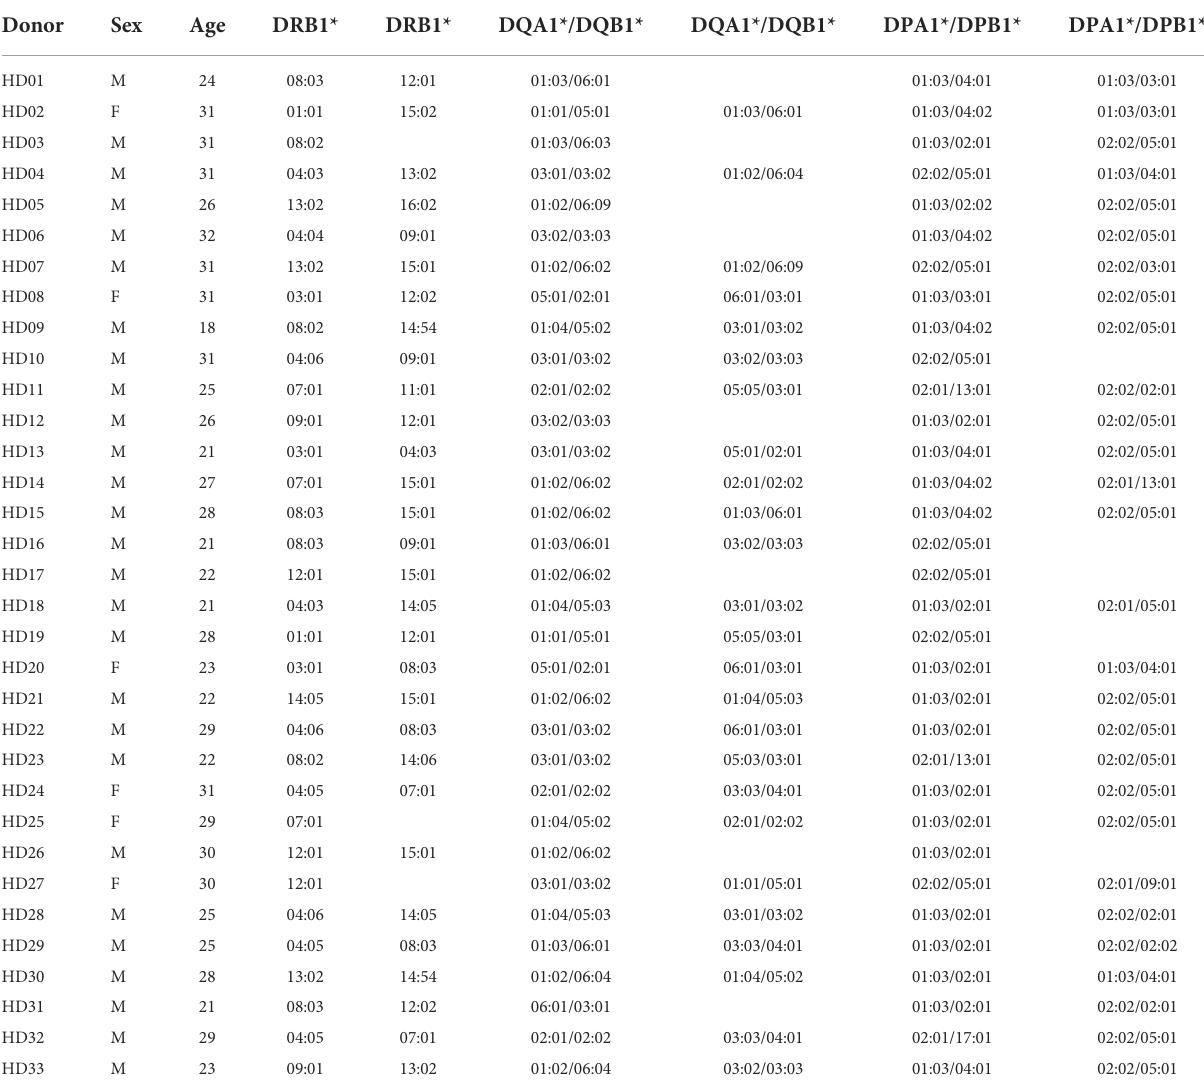
TABLE 1 Genotypes of HLA class II in 33 healthy